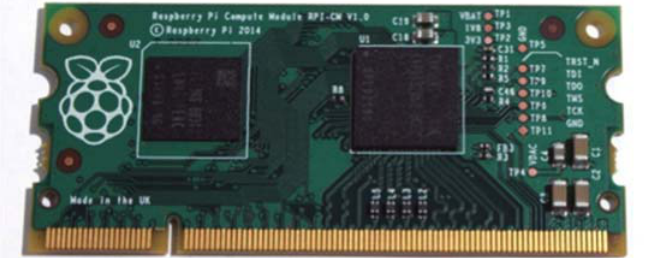
Figure 7. The RPI Compute Model; 67.6 × 30 mm board as DDR2 SODIMM (Source: Raspberry PI